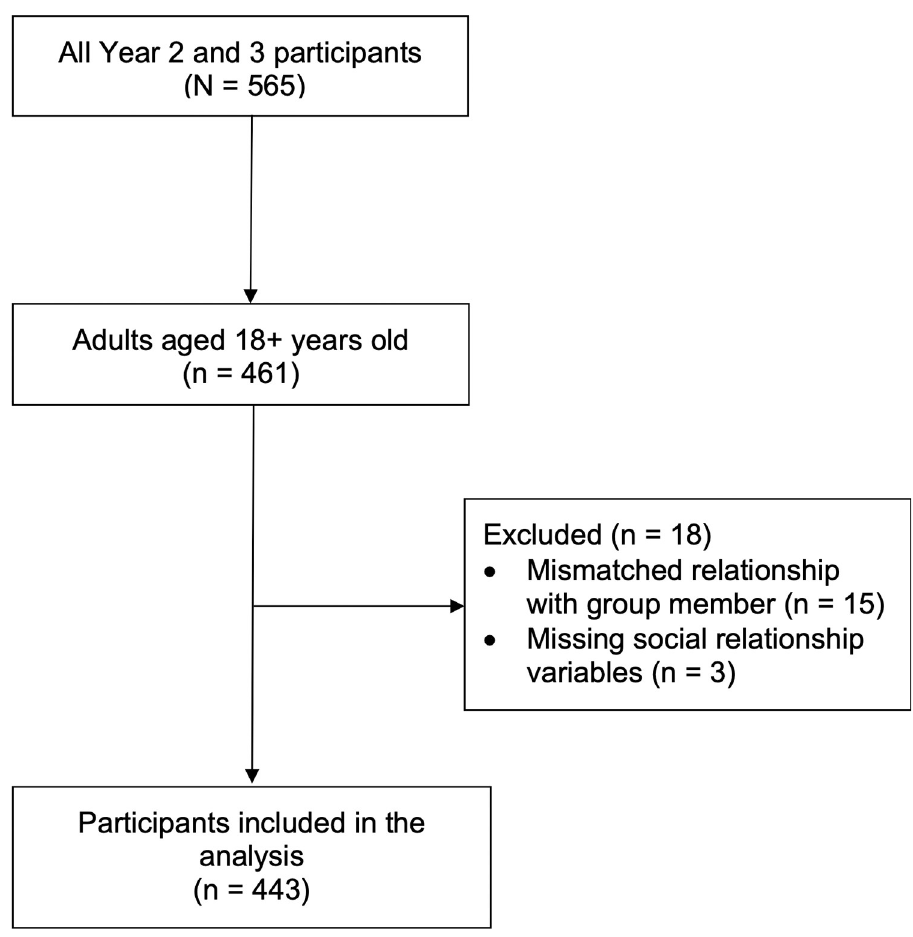
Fig 1. STROBE flow